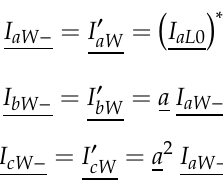
Figure 6. Joint vector diagram of phases A, B and C.